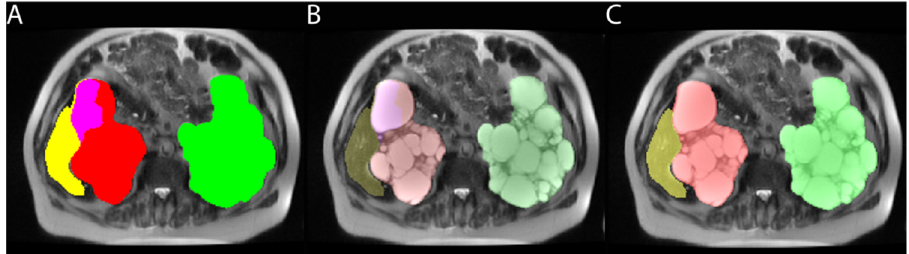
Figure 2. Axial T2 weighted image of a 67-year-old male with ADPKD showing: ( A ) pink voxels between liver (yellow) and right kidney (red) because they met the 2D model criteria for both kidney and liver. ( B ) same image as ( A ) but with increased transparency of labels to show that the pink overlap voxels correspond to a right renal cyst. ( C ) corrected image with overlap voxels now assigned to red corresponding to the right kidney.